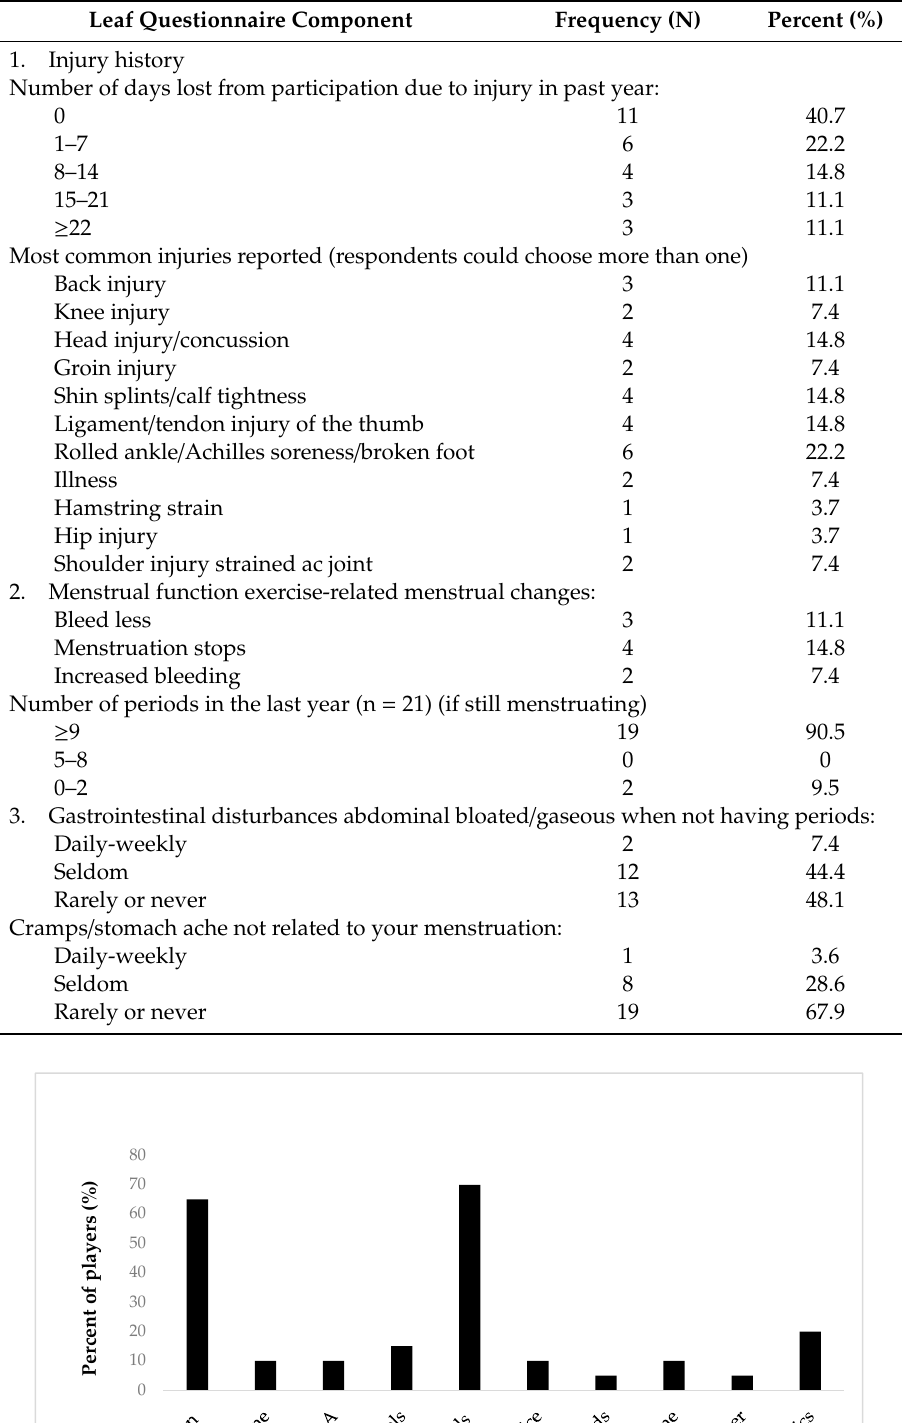
Table 6. Responses to key components of the LEAF-Q (n = 27).